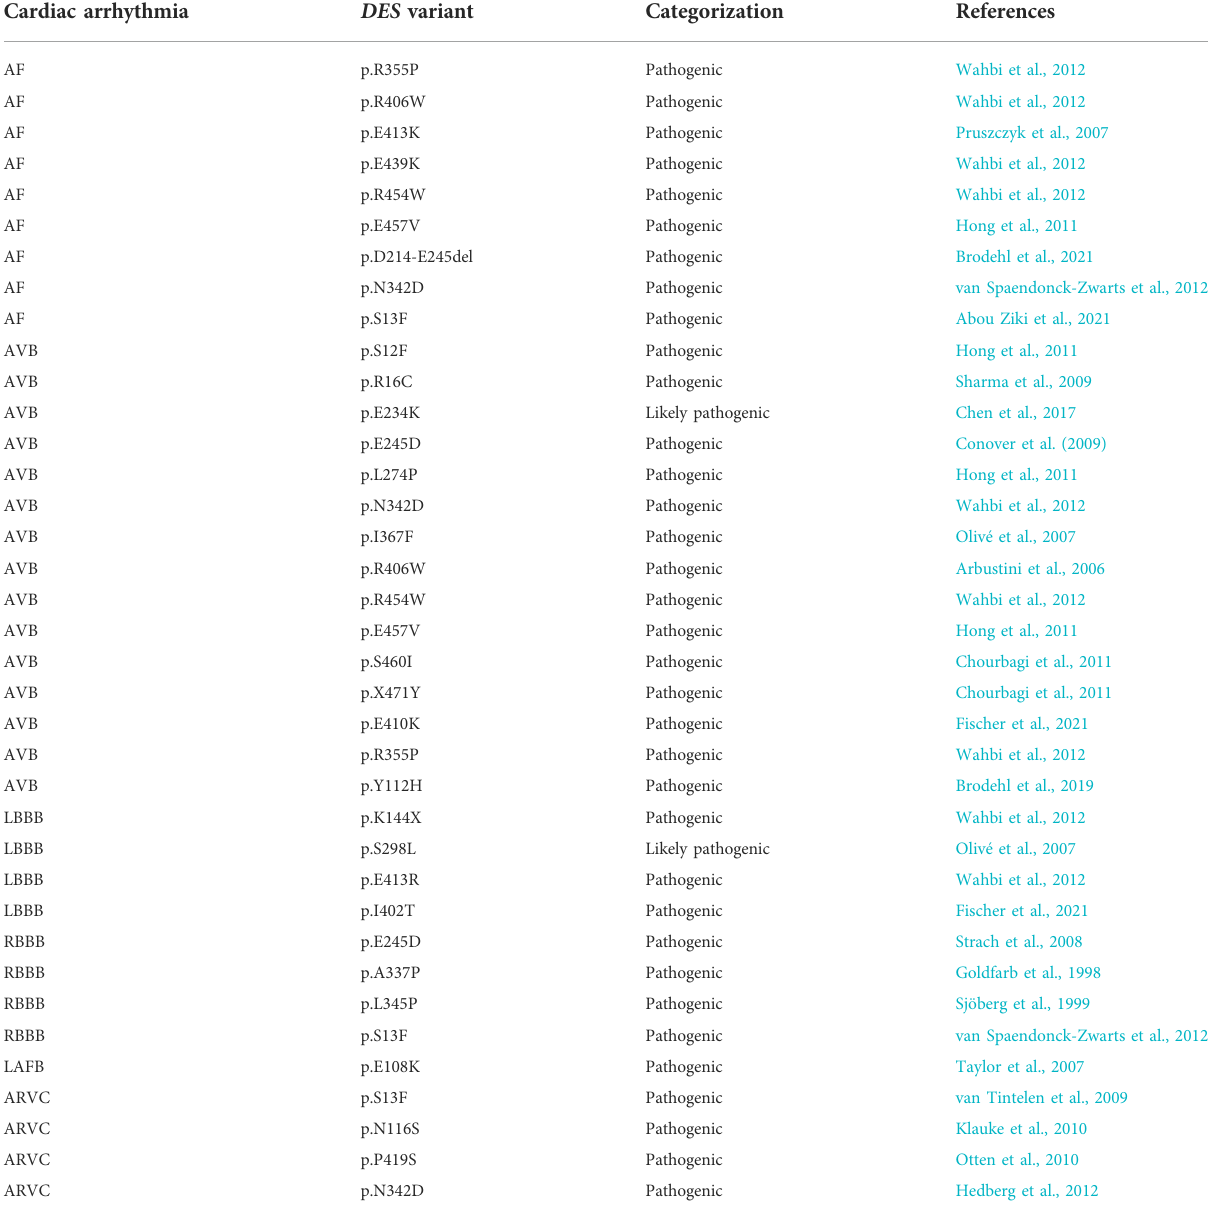
TABLE 1 Overview of different types of cardiac conduction disease and arrhythmias related to DES variant